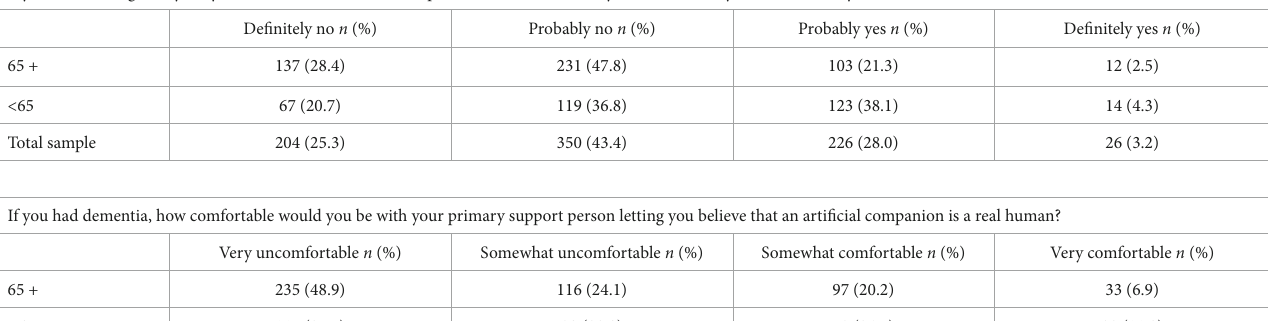
TABLE 2 Response frequencies, n =